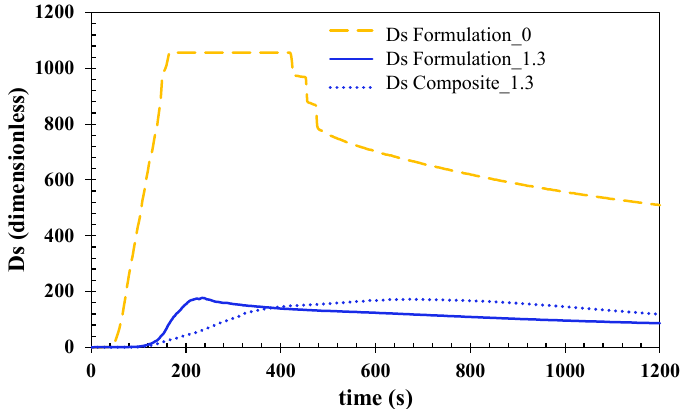
Figure 8. Smoke optical density (Ds) evolution over time of tested cast formulations and composite. One thousand and fifty-six is the maximum value that was measurable using the equipment.